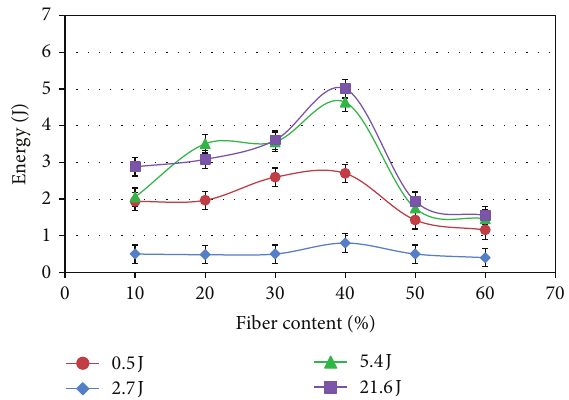
Figure 7: Effect of fiber content on impact energy of kenaf/PVB composites at different energy